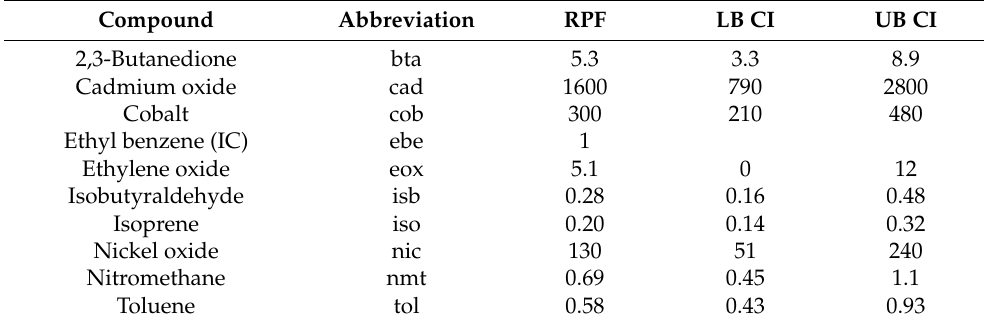
Table A2. Relative potency factors based on increased relative liver weight.